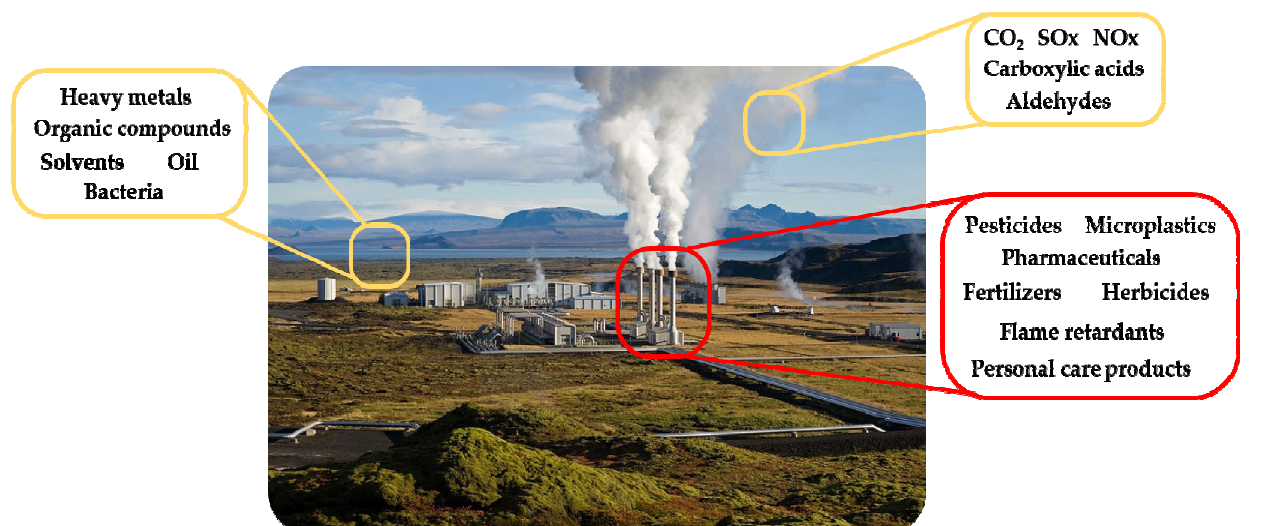
Figure 1. Common (yellow) and emerging (red) worldwide environmental contaminants.